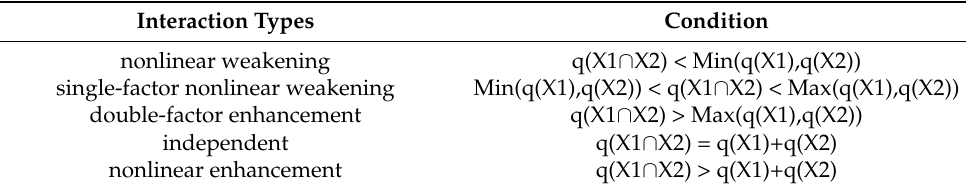
Table 3. The results of interaction